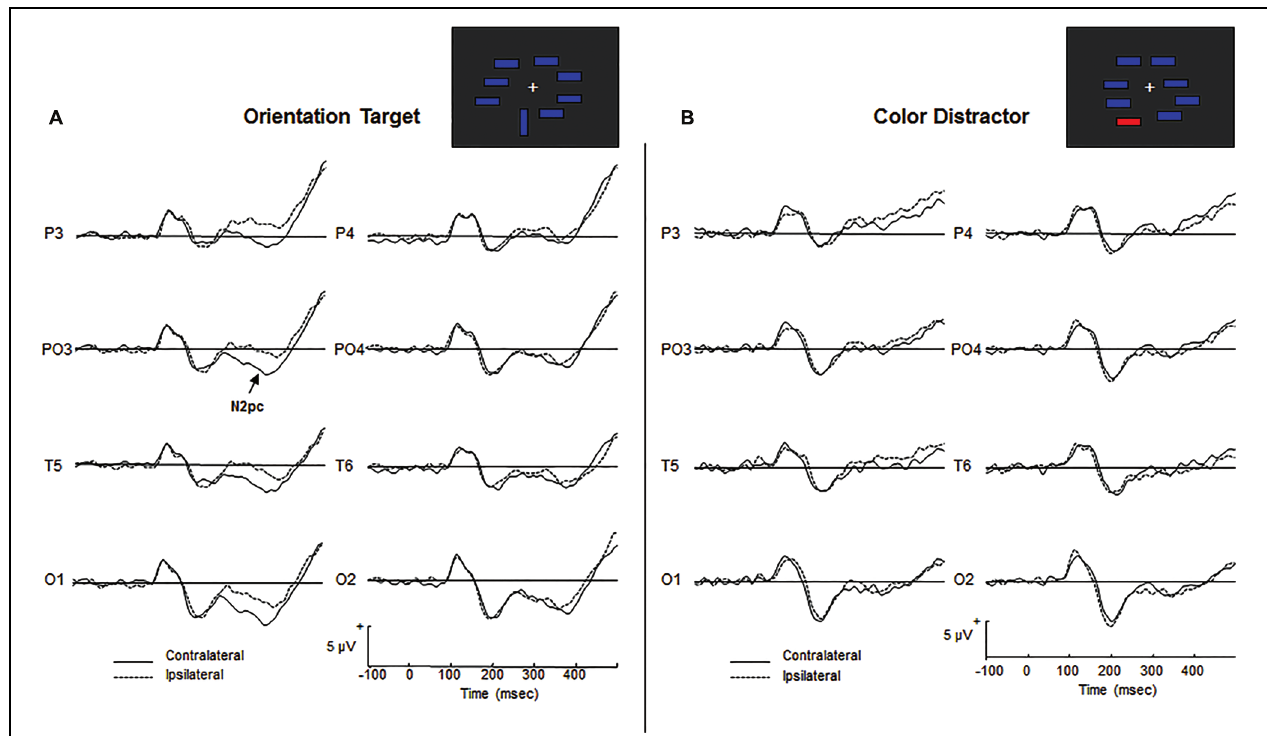
FIGURE 2 | (A) Grand-average ERPs for targets. Superimposed are responses to targets presented in the contralateral (solid lines) and ipsilateral (dashed lines) visual field to electrode locations. (B) Grand-average ERPs for irrelevant non-targets. Superimposed are responses to non-targets presented in the contralateral (solid lines) or ipsilateral (dashed lines) to electrode locations. The N2pc component is absent.